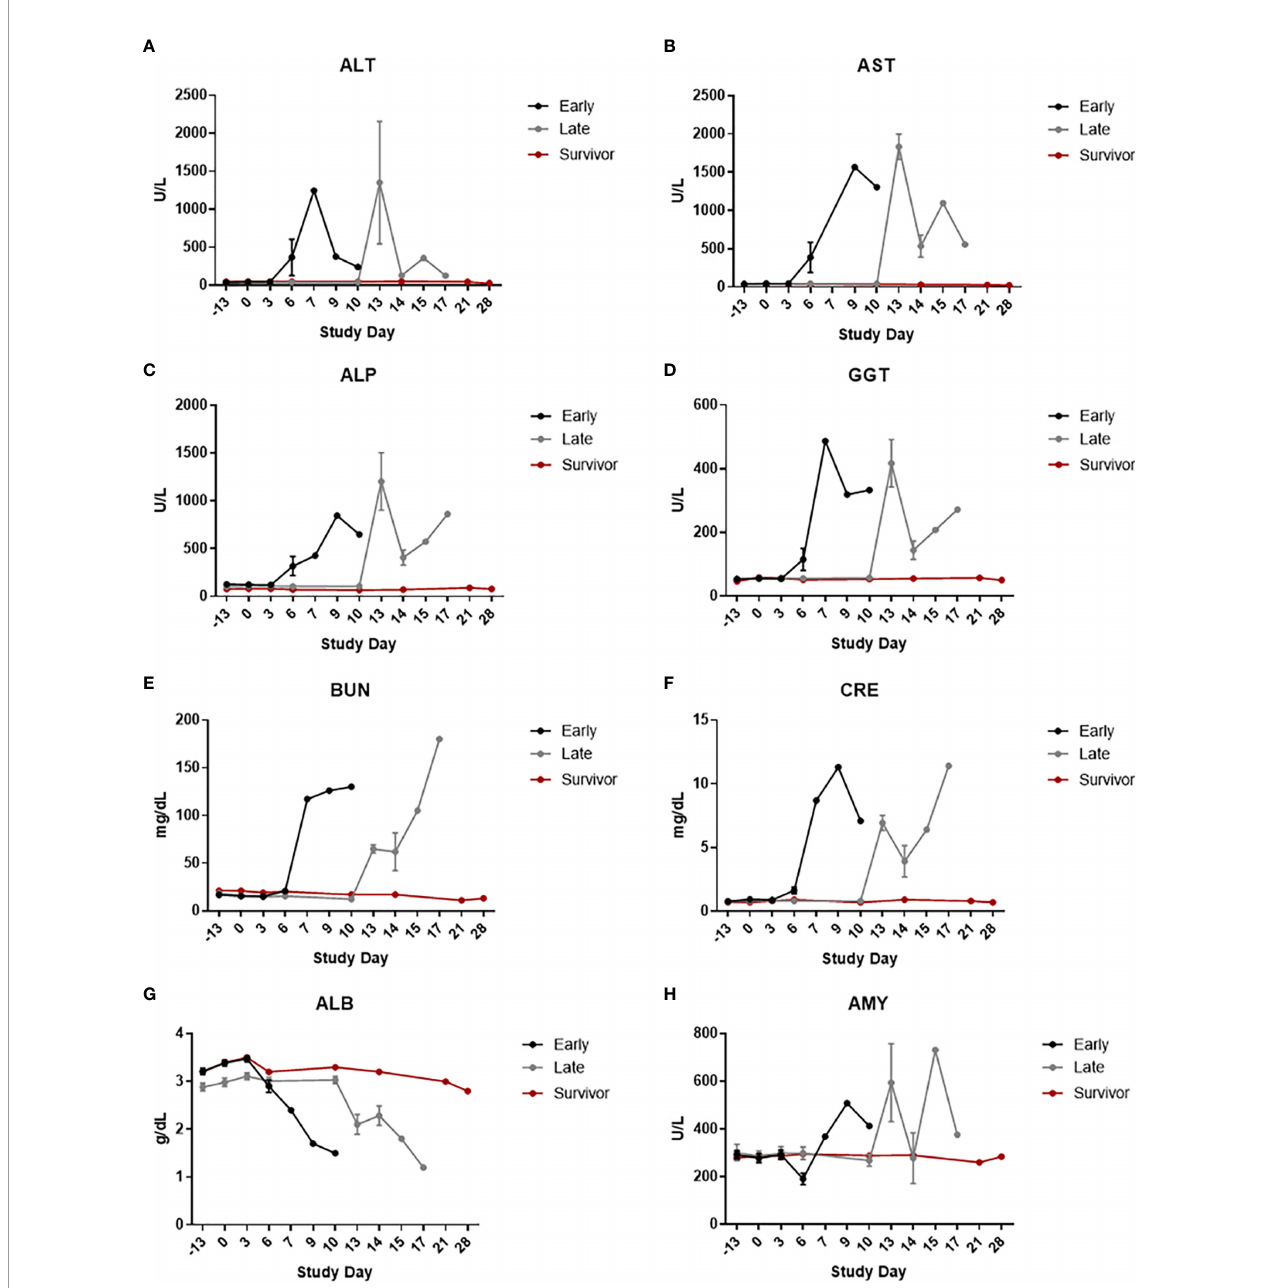
FIGURE 4 | Clinical Chemistries. Serum clinical chemistry data was generated using Piccolo Point-Of-Care instruments. The graphs in this fi gure show data grouped by survival phase (i.e., early-phase, late-phase, and survivor). (A) ALT; (B) AST; (C) ALP; (D) GGT; (E) BUN; (F) CRE; (G) ALB; (H) AMY. Error bars represent the